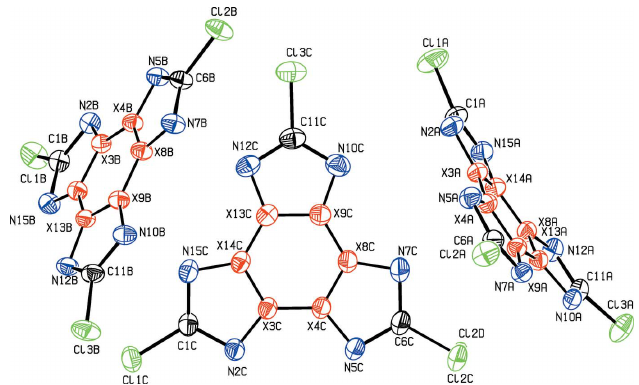
Figure 1 The three independent molecules in the title compound. Displacement ellipsoids are drawn at the 50% probability level. The atoms depicted with X are statistically occupied by C and N